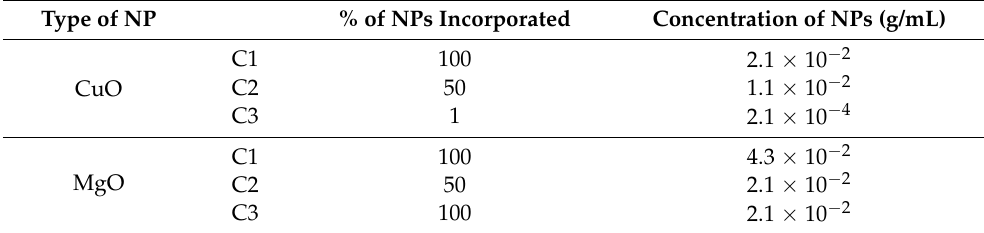
Table 1. Concentrations of metal oxide NPs (CuO and MgO) used in spectroscopic analysis during washing